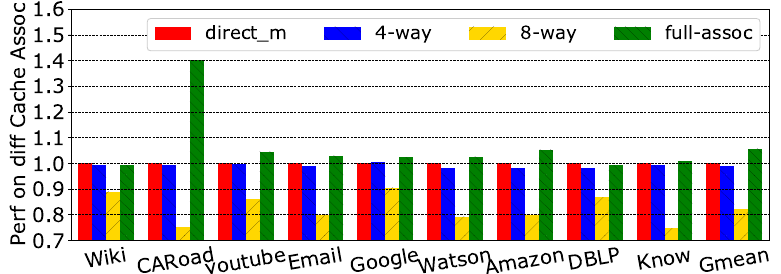
Figure 15. Performance comparison for different on-chip cache